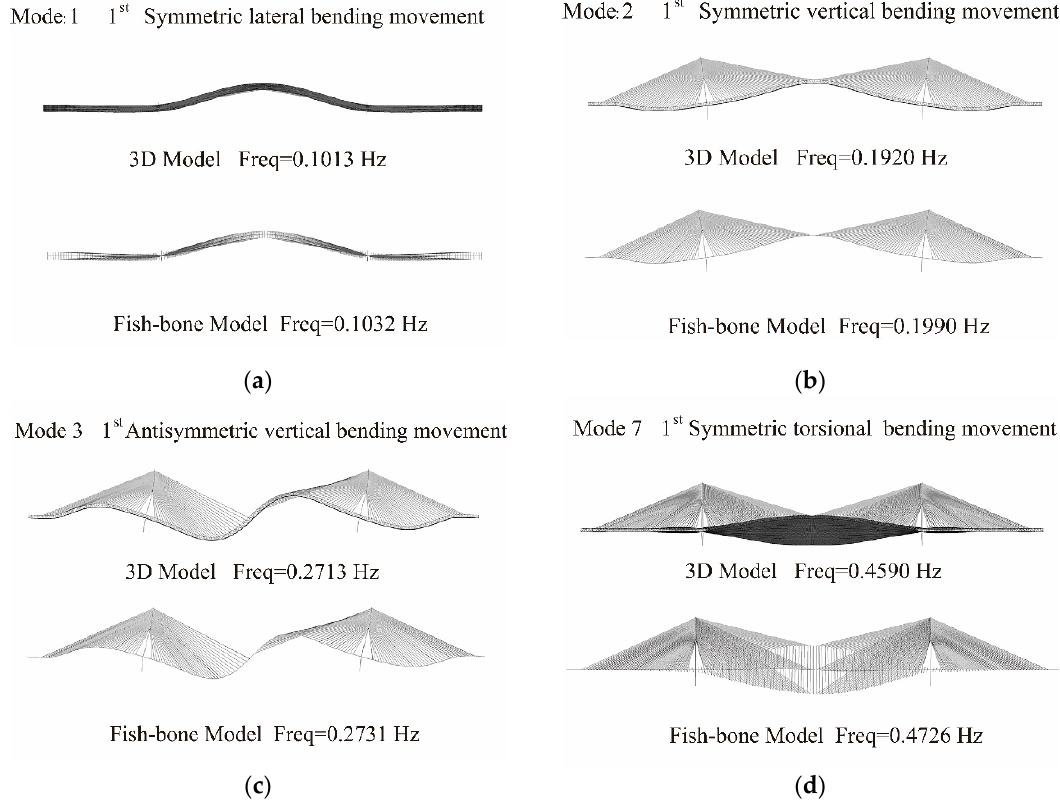
Figure 15. Mode shape comparisons of the 3D and fish-bone models: ( a ) Mode 1; ( b ) Mode 2; ( c )Mode 3; ( d ) Mode 7.